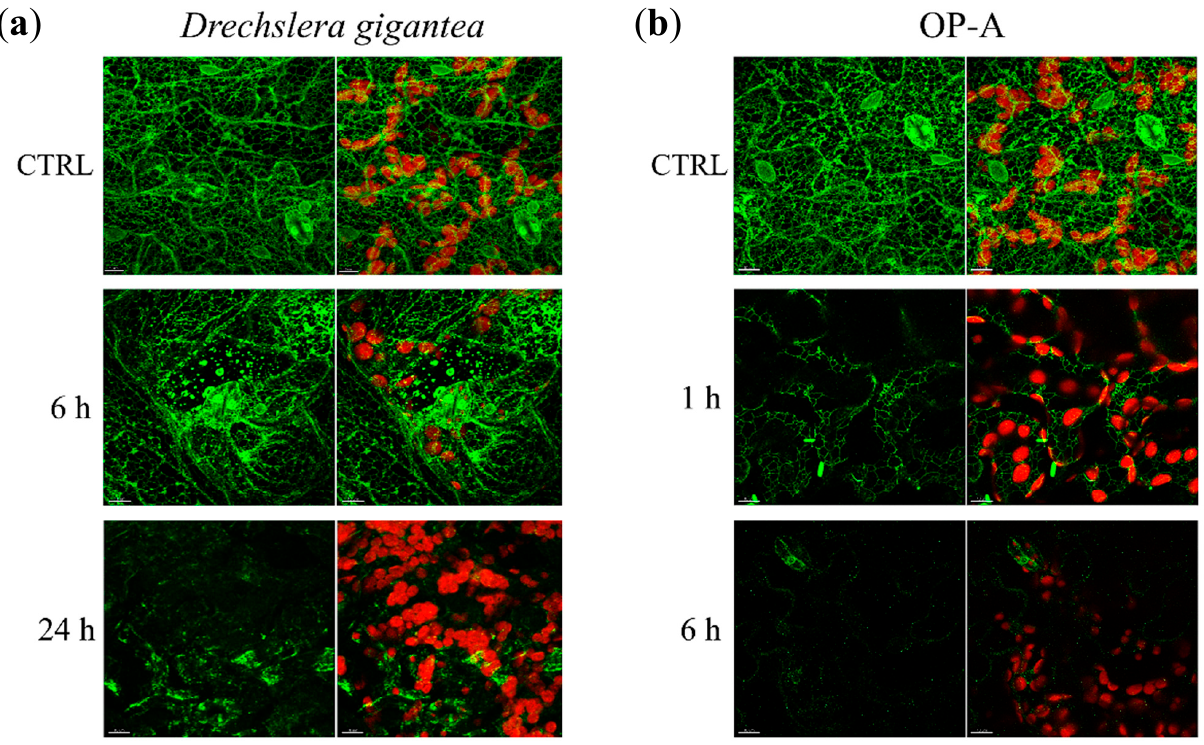
Figure 5. Confocal microscope imaging of ER network of Arabidopsis leaves: infected by D. gigantea ( a ) or infiltrated with OP-A ( b ). ( a ) Leaves of GFP-tmKKXX-expressing WT Arabidopsis plants were inoculated or not with a suspension of D. gigantea conidia (500,000/mL); after 6 and 24 h from infection, they were analyzed by confocal microscope at 488 nm (argon laser) for GFP excitation. ( b ) Leaves of GFP-tmKKXX-expressing WT Arabidopsis plants were detached from plants, incubated with 20 µ M OP-A for 1 and 6 h, as reported in Section 2.11, and analyzed by confocal microscope at 488 nm (argon laser) for GFP excitation. Left, GFP fluorescence (green). Right, merged chloroplast autofluorescence (red), and GFP fluorescence (green) images. Bar = 10 µ